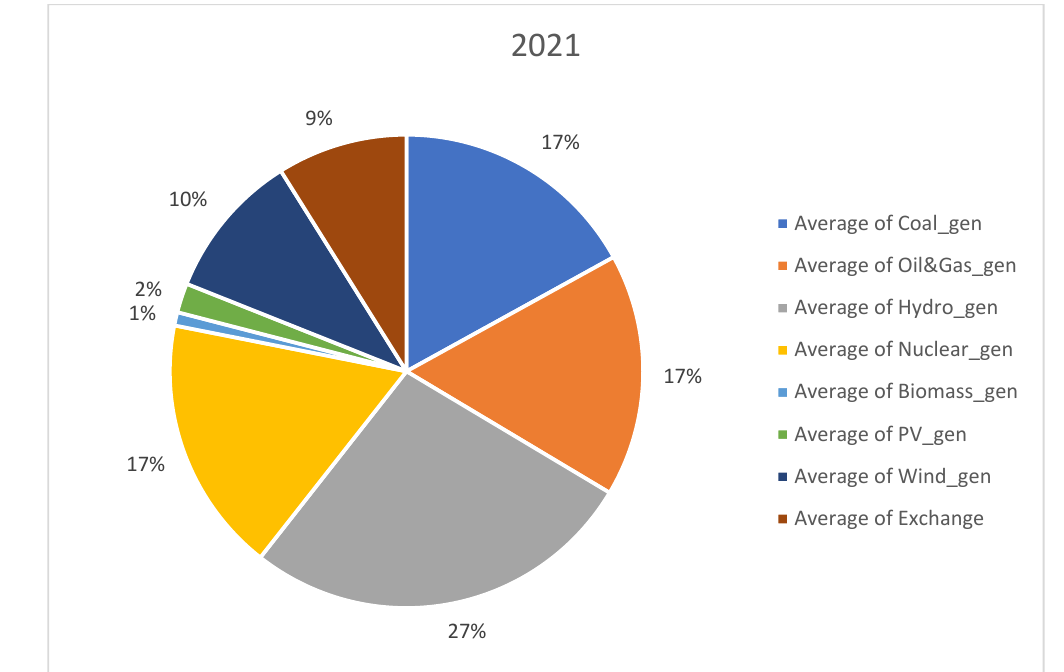
Figure 3. Distribution of generation sources in 2021.